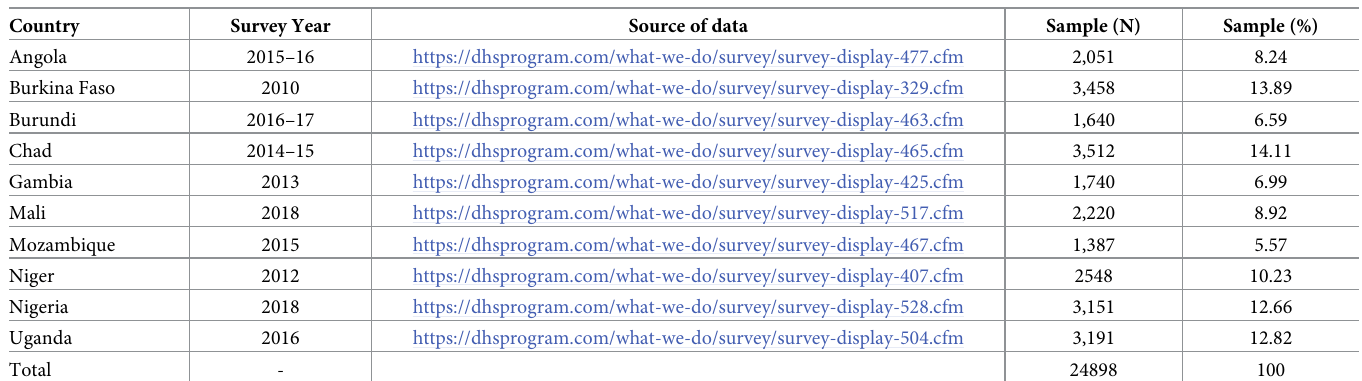
Table 1. Survey and sample size